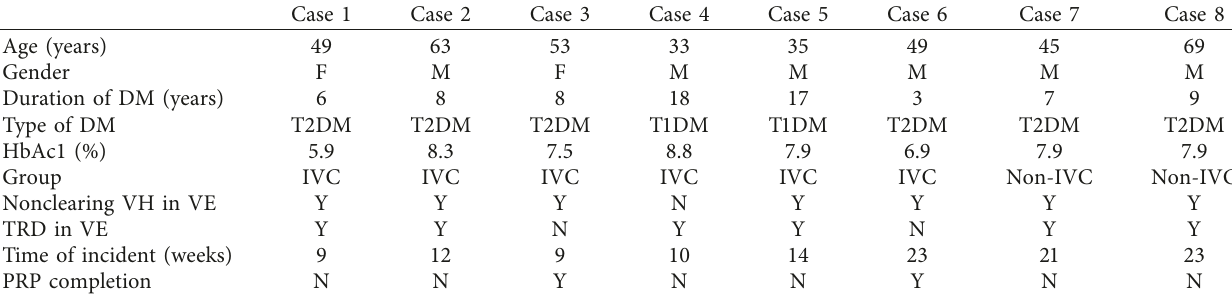
Table 4: Details of cases that progressed into tractional retinal detachment in the fellow